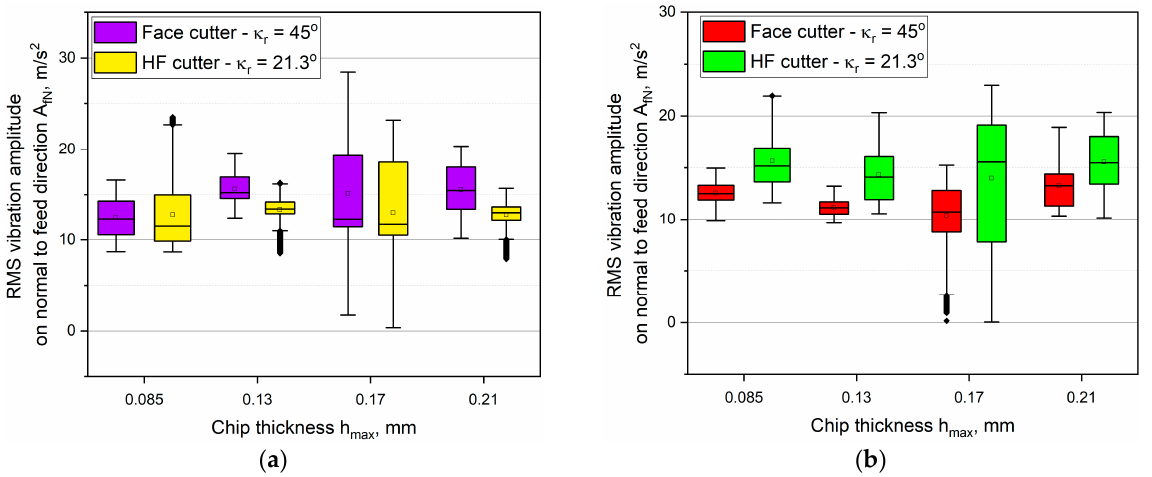
Figure 10. The influence of the chip thickness on the vibration amplitude values in the normal to feed direction A fN : ( a ) up milling, ( b ) down milling.